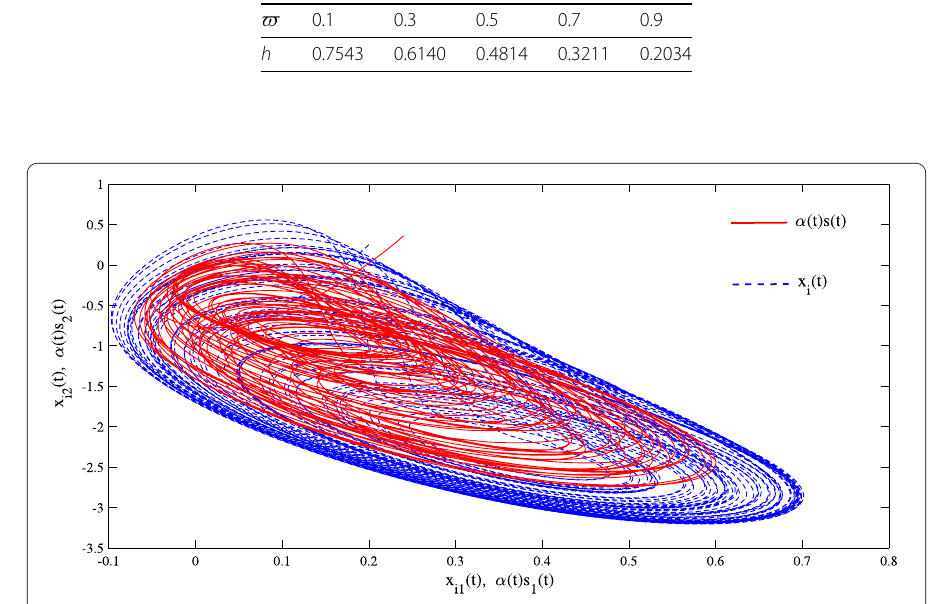
Figure 4 The trajectory of the isolated node (42) and network (1) with the time-varying scaling function